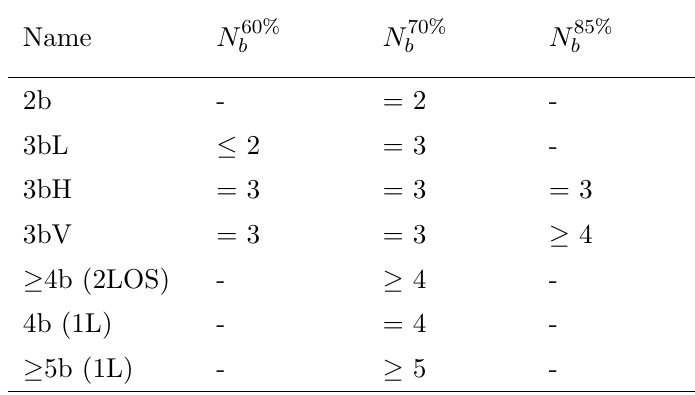
Table 1 . Summary of the b -tagging requirements for the event categorisation. Events in each category must satisfy all requirements listed in columns. N 60% numbers of b -tagged jets obtained using b -tagging operating points with average expected efficiencies of 60%, 70% and 85%, respectively. The 3bL (3bH) requirement selects events with lower (higher) purity of MC ‘truth’ b -jets amongst the three jets tagged at the 70% OP. The 3bV requirement is used to define the validation regions. The symbol ‘-’ indicates that no requirement is applied.